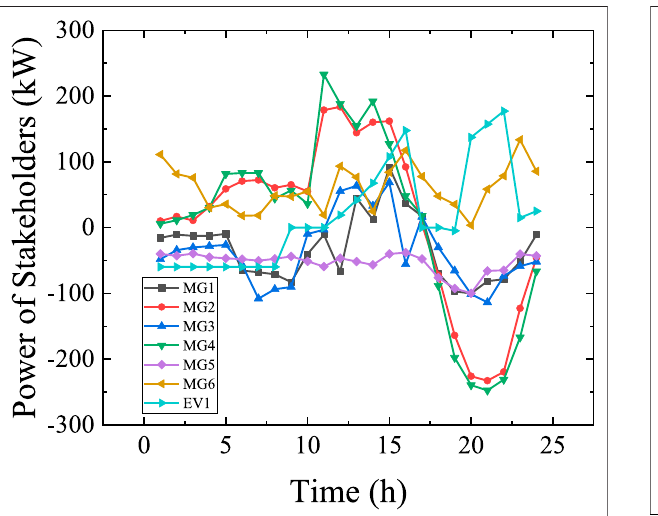
FIGURE 4 | Power prediction curves of the MGs.and EV1.